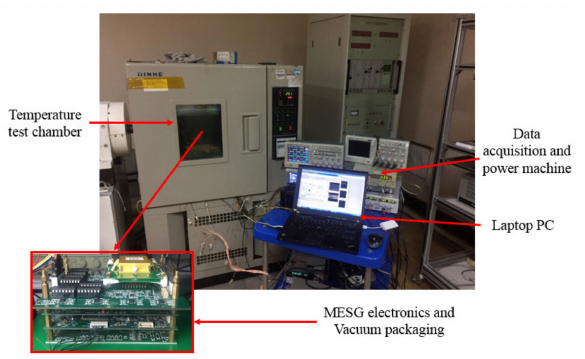
Figure 11. Set-up of the temperature drift testing.